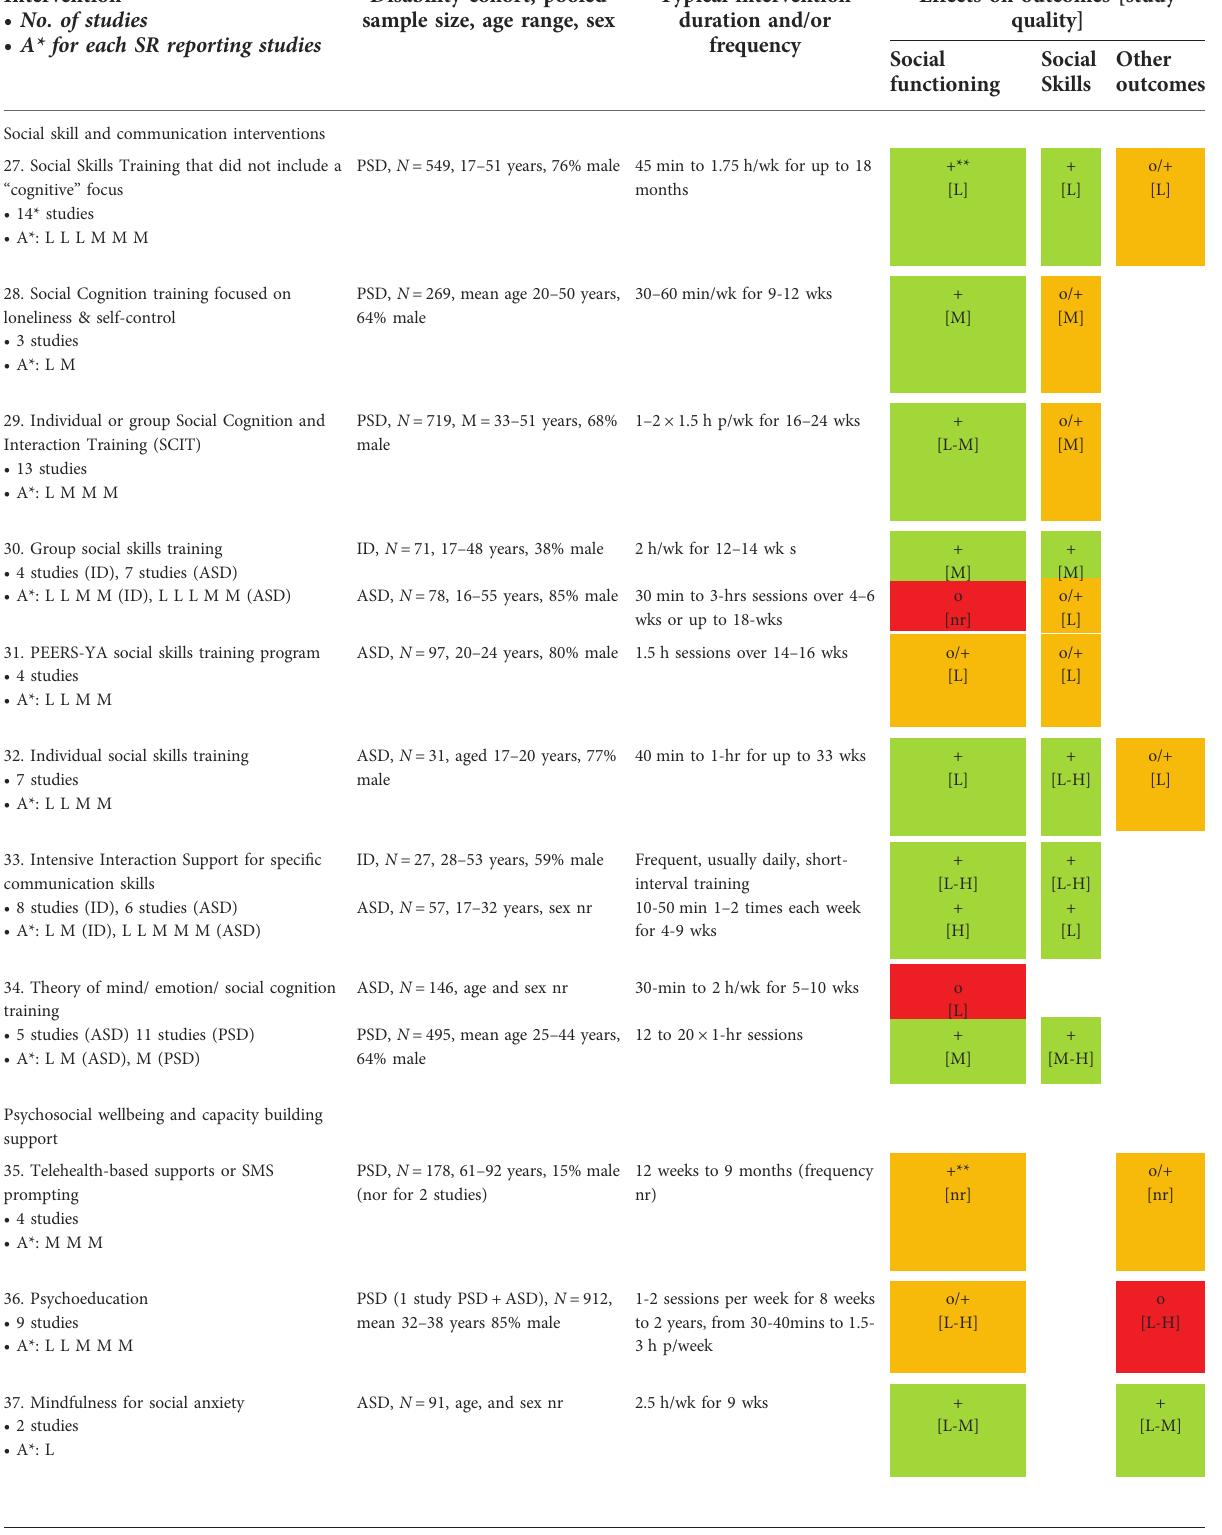
TABLE 4 Overall effects of interventions to build skills, psychosocial wellbeing, and broader capacity to participate socially and in the community, including AMSTAR quality rating of the SRs and quality of the original studies. Intervention (cid:129) No. of